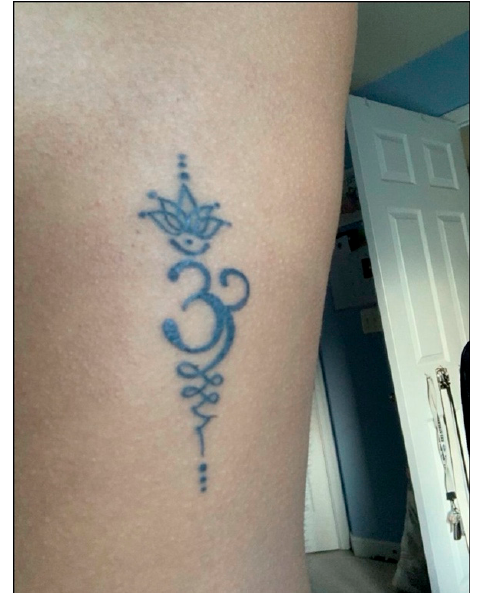
Figure 3. Maia’s Om tattoo, matching with her mother.